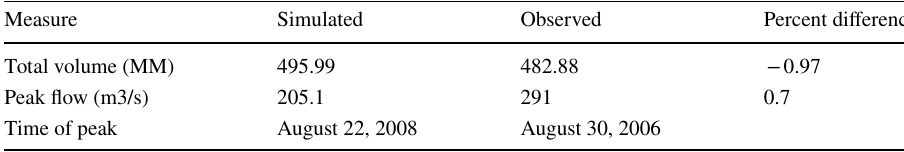
Table 16 Calibrated model parameters green and Ampt loss method